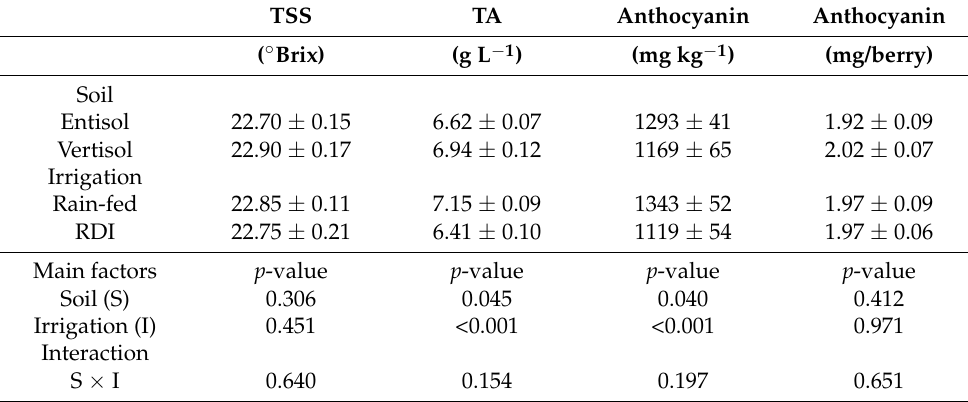
Table 6. Effects of soil and irrigation on total soluble solids (TTS), titratable acidity (TA), anthocyanin concentration (mg kg − 1 of grapes) and anthocyanin content (mg/berry) of ‘Nero d’Avola’ grapevines grown in two soils (entisol and vertisol) and under rain-fed and regulated deficit irrigation (RDI) treatments. Means ± standard errors and p -values from two-way ANOVA. TSS TA Anthocyanin Anthocyanin ( ◦ Brix) (g L − 1 ) (mg kg − 1 )